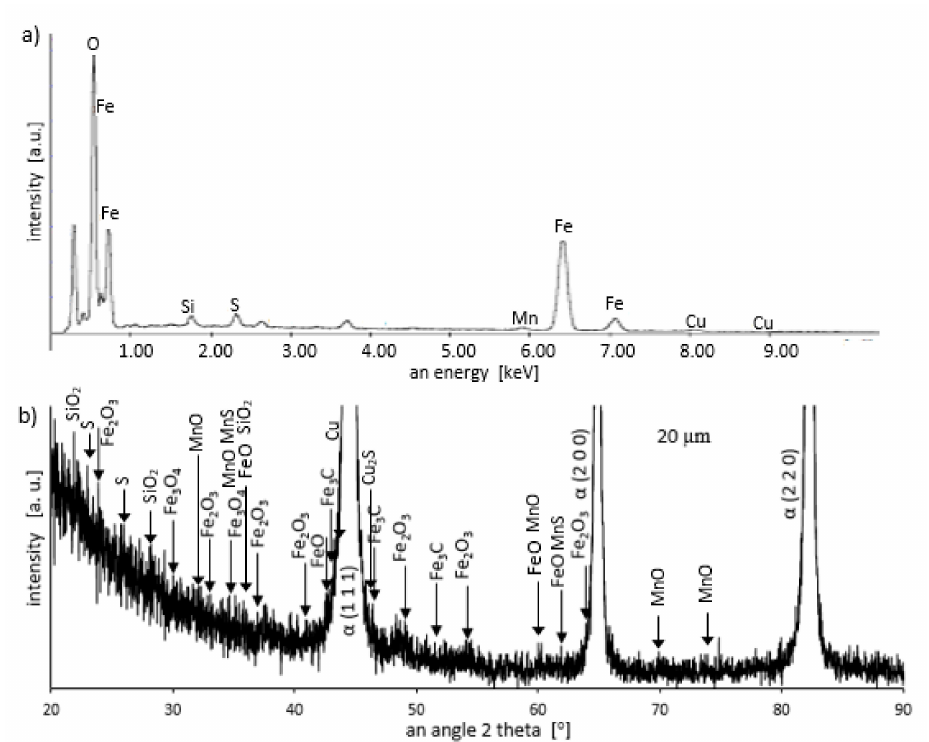
Figure 7. Energy dispersive spectroscopy (EDS) spectrogram ( a ) and X-ray di ff ractometer (XRD) pattern ( b ) for a sample grinded to a depth of 20 µ m.